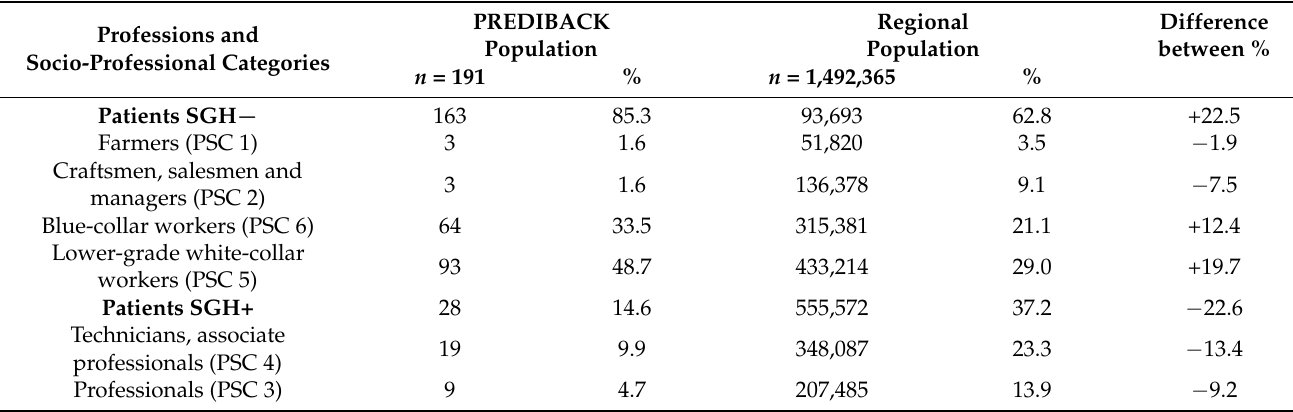
Table 1. Comparison between occupational categories of patients in the PREDIBACK study and the regional population aged between 40 and 64 years in